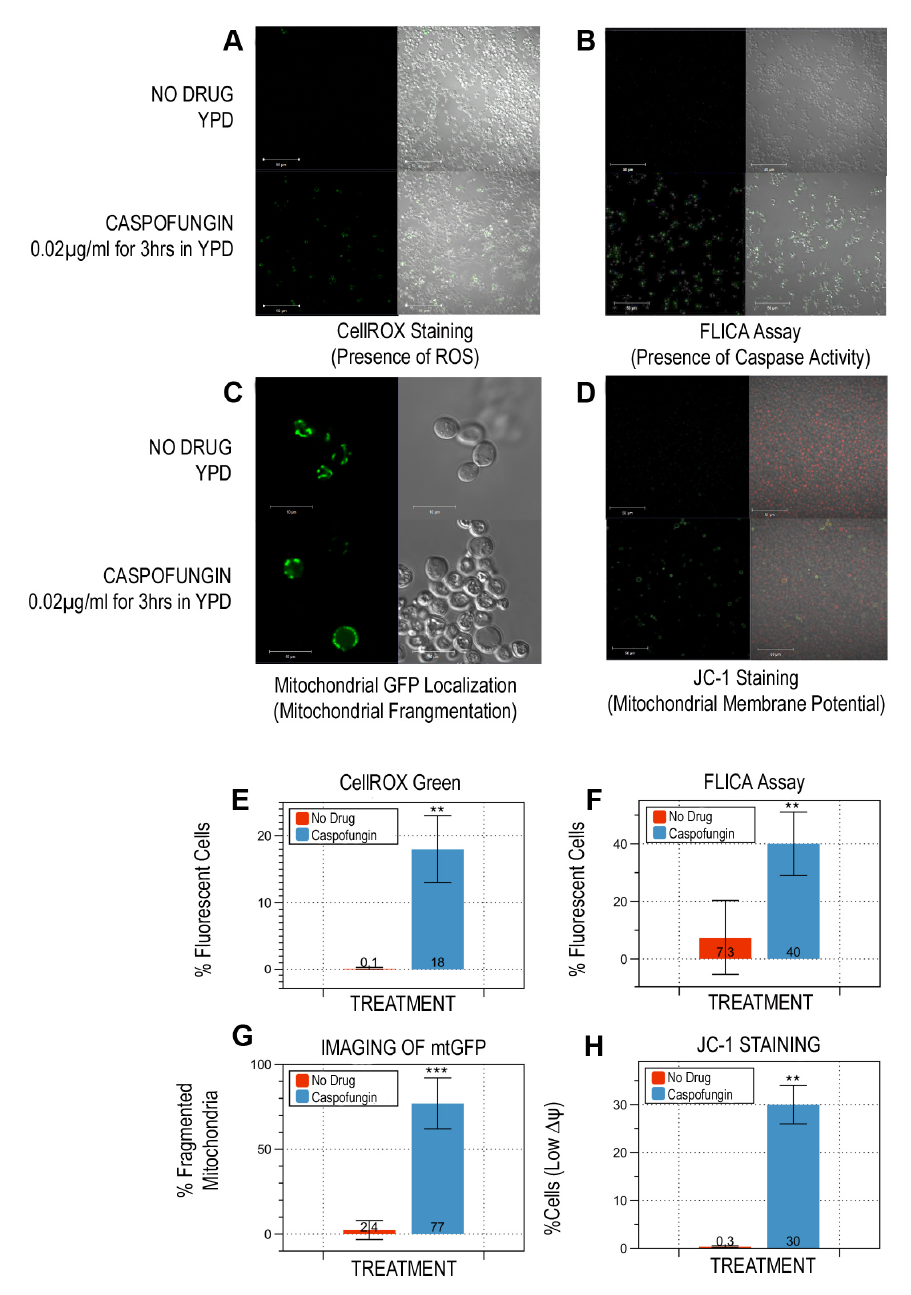
FIGURE 1: Saccharomyces cerevisiae cells cultured in caspofungin manifest numerous phenotypic markers associated with yeast pro- grammed cell death. Exponentially-growing wildtype cells from the W303-1A strain background were cultured in YPD containing 0.02µg/ml caspofungin for three hours. The cells were stained with 2.5µM CellROX Green to detect ROS (A, E) ; with a FLICA kit to detect activated caspase activity (B, F) ; and with the mitochondrial vital dye, JC-1, to assess their mitochondrial membrane potential (D, H) . To visualize the structure of their mitochondria, the cells were transformed with a p416 GPD-mtGFP plasmid constitutively expressing a mi- tochondria-localized GFP marker and their mitochondria were visualized after they had been treated with caspofungin as described above (C, G) . Representative images are shown (A-D) . Statistical significance for the graphs (E-H) was determined with the unpaired Student’s t- test (**: p<0.05; ***: p<0.005), and a minimum of 500 cells was counted for each